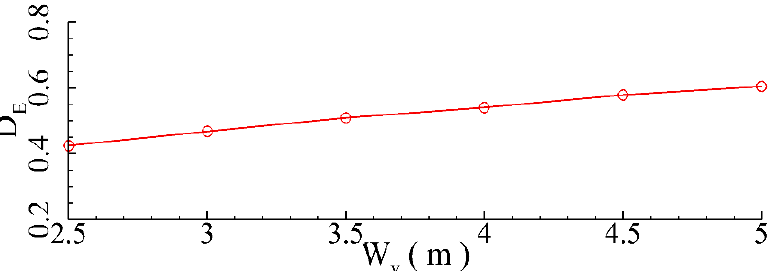
Figure 32. Wave energy dissipation rate under different vegetation lengths.